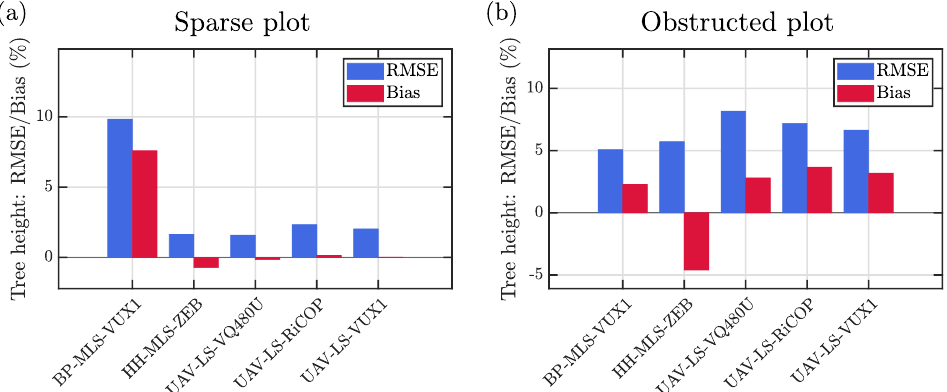
Figure 11. Relative bias and RMSE of tree height estimation at the individual tree level for the different methods ( a ) in the sparse plot and ( b ) in the obstructed plot. BP and HH stand for backpack and handheld, respectively. Note that the scales of the y axes are different in panels ( a , b